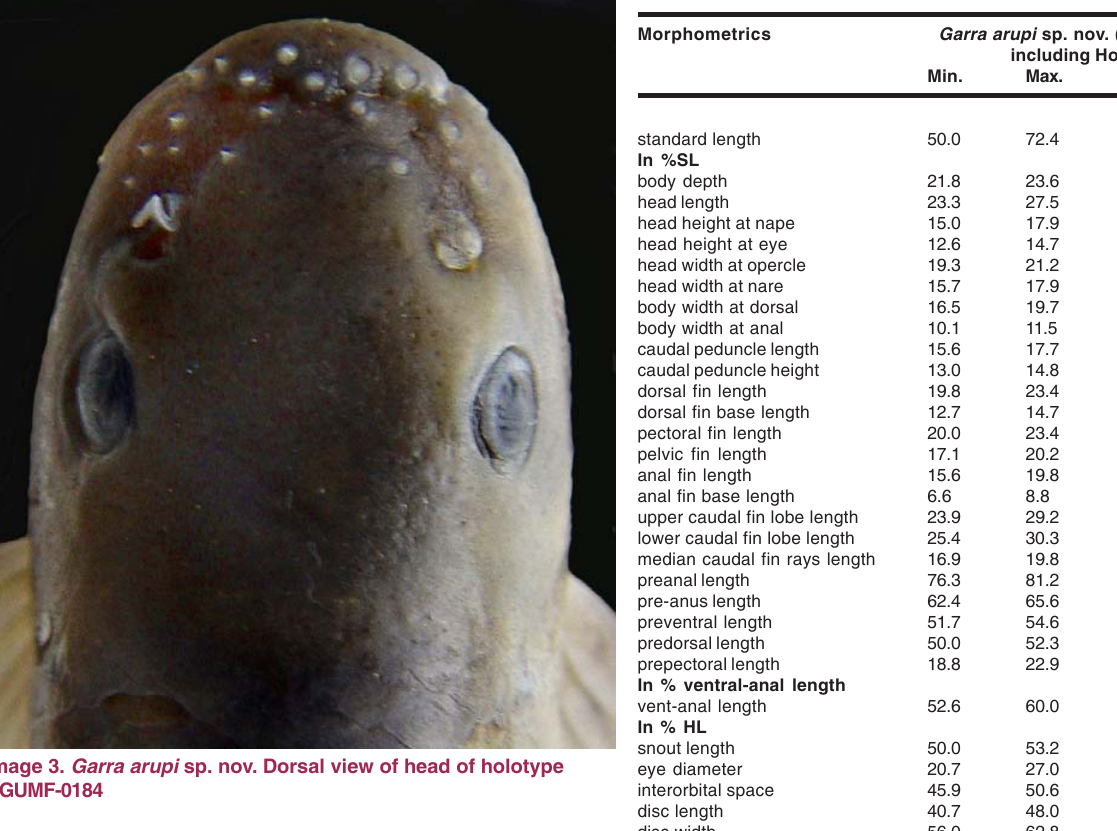
Table 1. Morphometric characteristics of Garra arupi sp. nov.